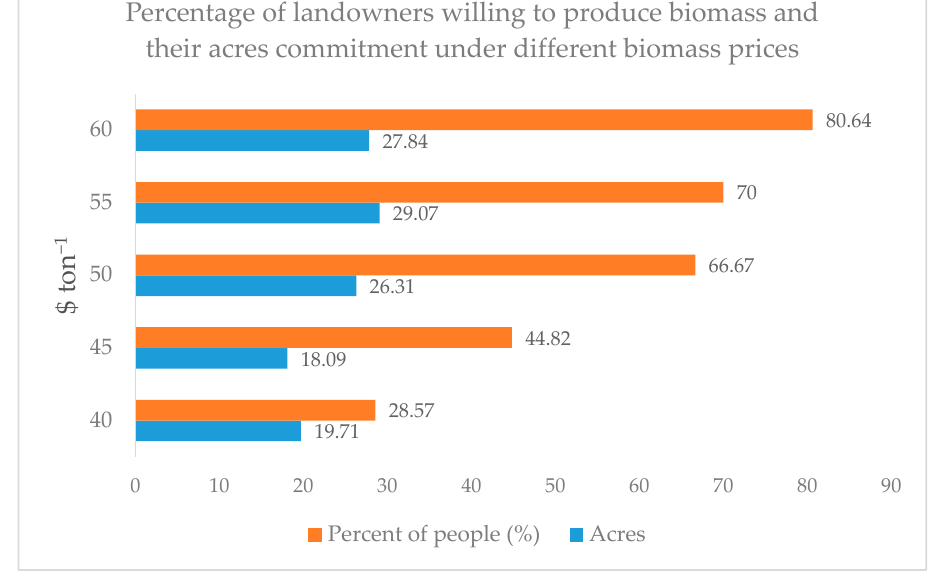
Figure 2. Percentage of landowners willing to produce biomass at different biomass prices and their acreage commitment.